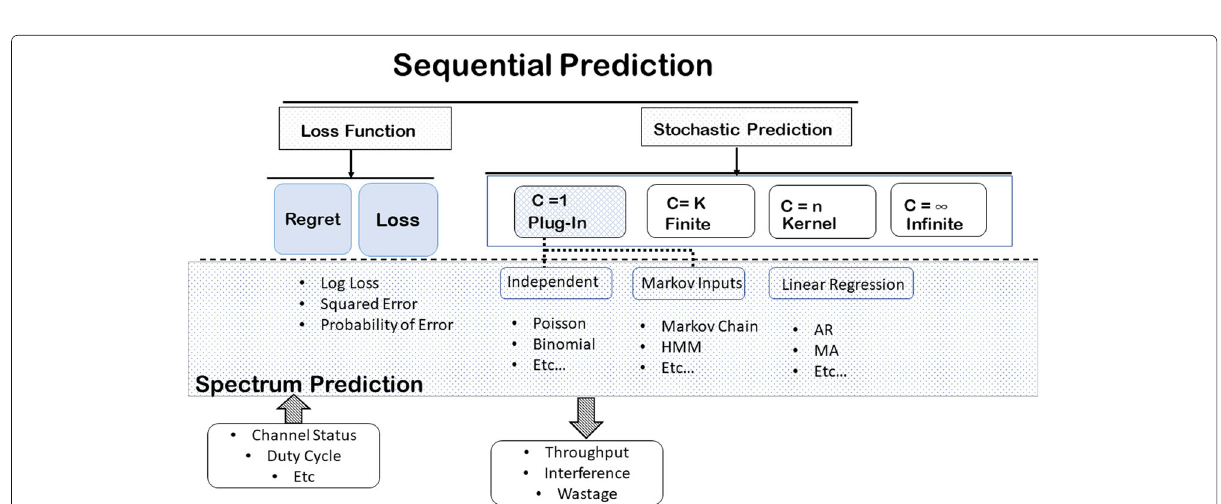
Fig. 5 Sequential prediction classification of spectrum prediction